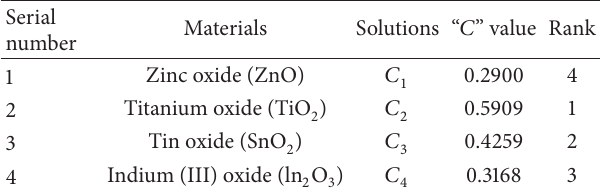
Table 2: Solution of study based on TOPSIS